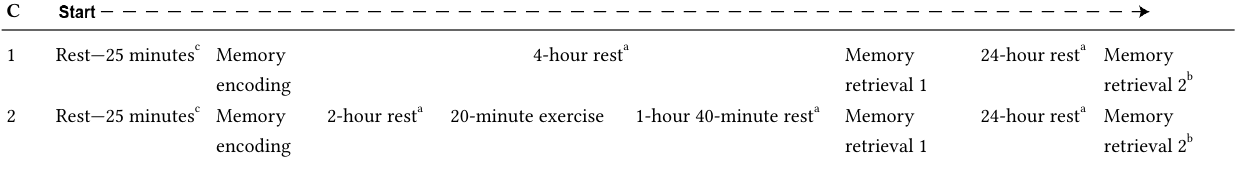
Memory Results (Words Recalled) for Experiment 3